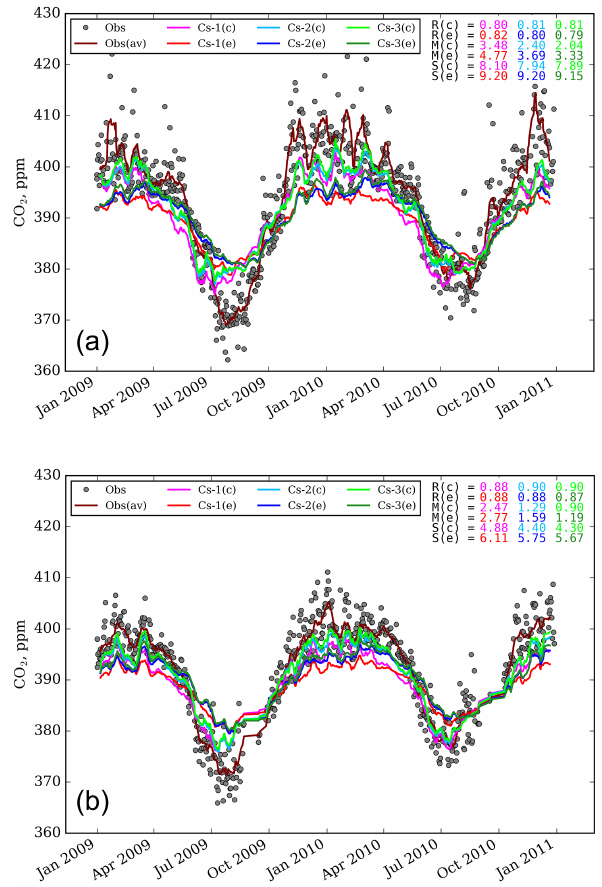
Figure 6. CO 2 mixing ratios observed at (a) the Igrim and (b) Vaganovo towers, and simulated using the coupled “(c)” and Eulerian-only “(e)” models using the setups from Table 1 for 2009– 2010. Symbols show individual observations; lines depict 2-week running averages. Here, R, M, and S signify the Pearson correla- tion, mean bias, and standard deviation